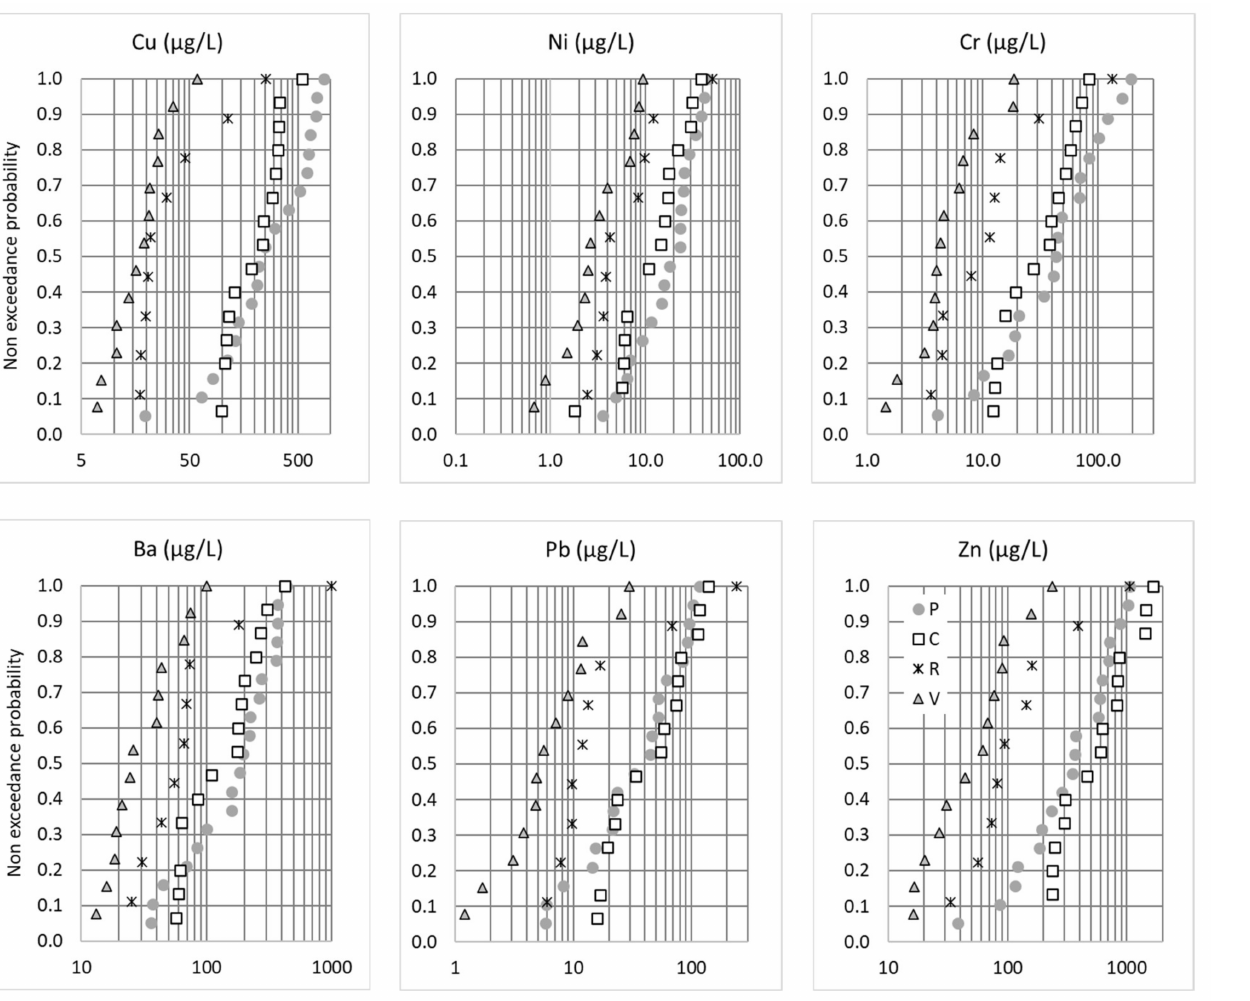
Figure 3. Non-exceedance probability distributions of the total EMCs ( µ g/L) for Cu, Ni, Cr, Ba, Pb and Zn. P = Paris, C = Compans, R = Rosny-sous-Bois and V =